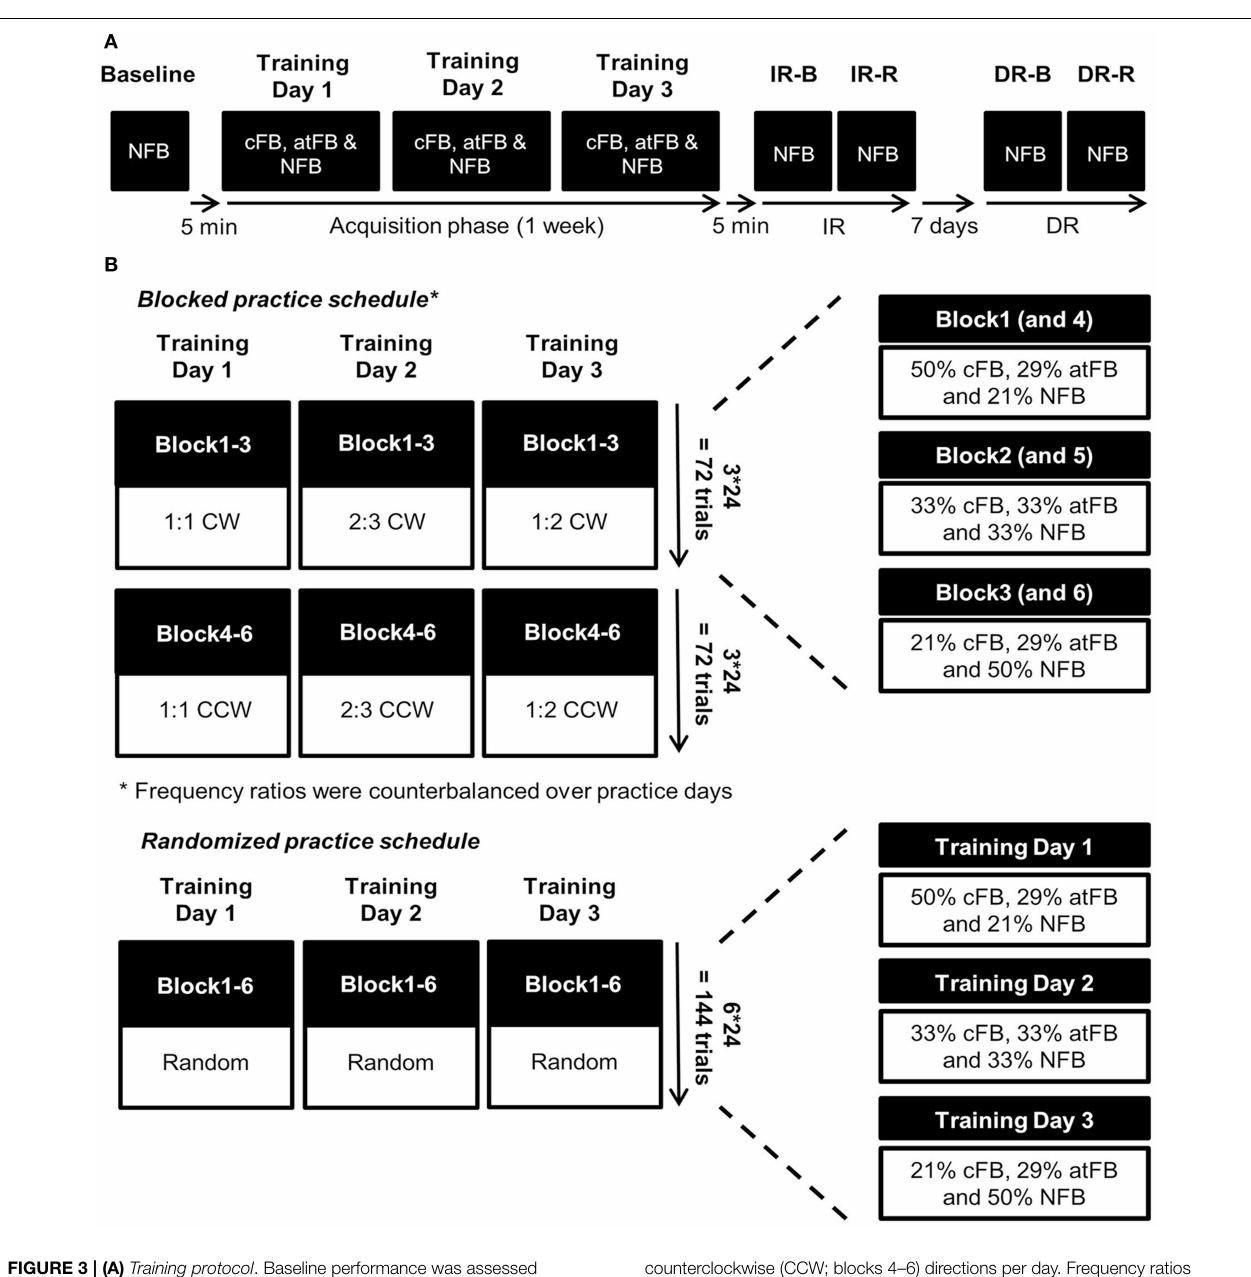
measures ANOVA was conducted to test the influence of CI on percentage forgetting from EoA to DR in both age